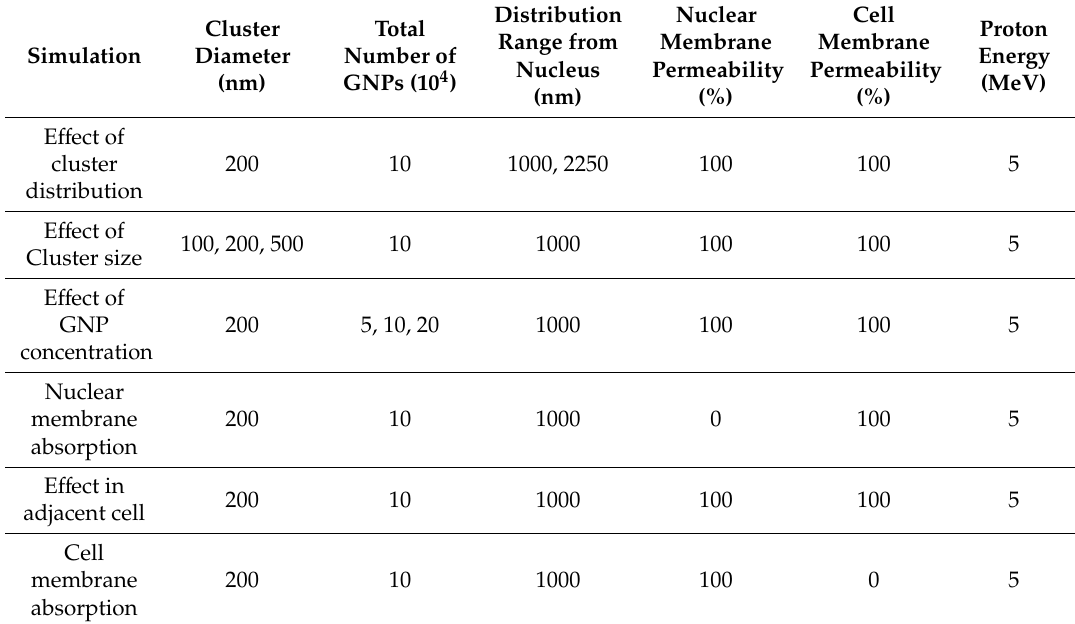
Table 2. Nanoparticle distribution, membrane permeability and proton parameters used in